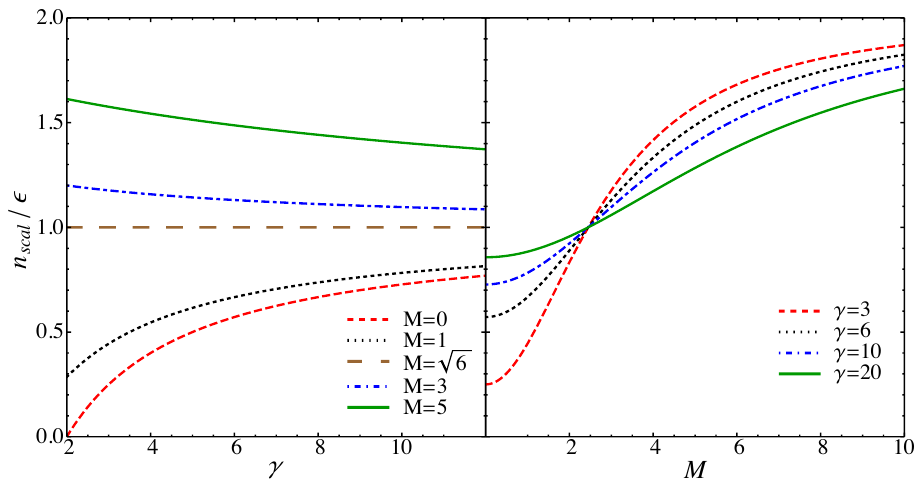
Figure 5 . The late-time decay rate of the scalar power spectrum for di(cid:11)erent values of (cid:13) and M